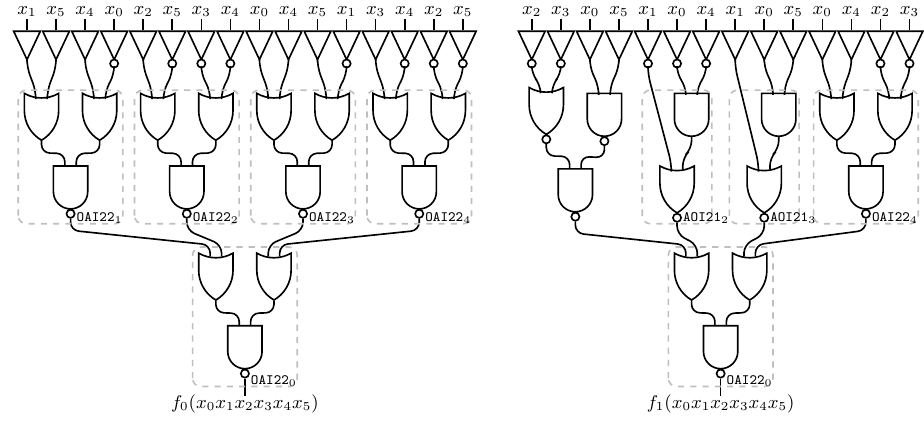
Figure 7: One of the optimized circuits for the representatives of the coordinate functions for 6-bit S-box in Example 4.